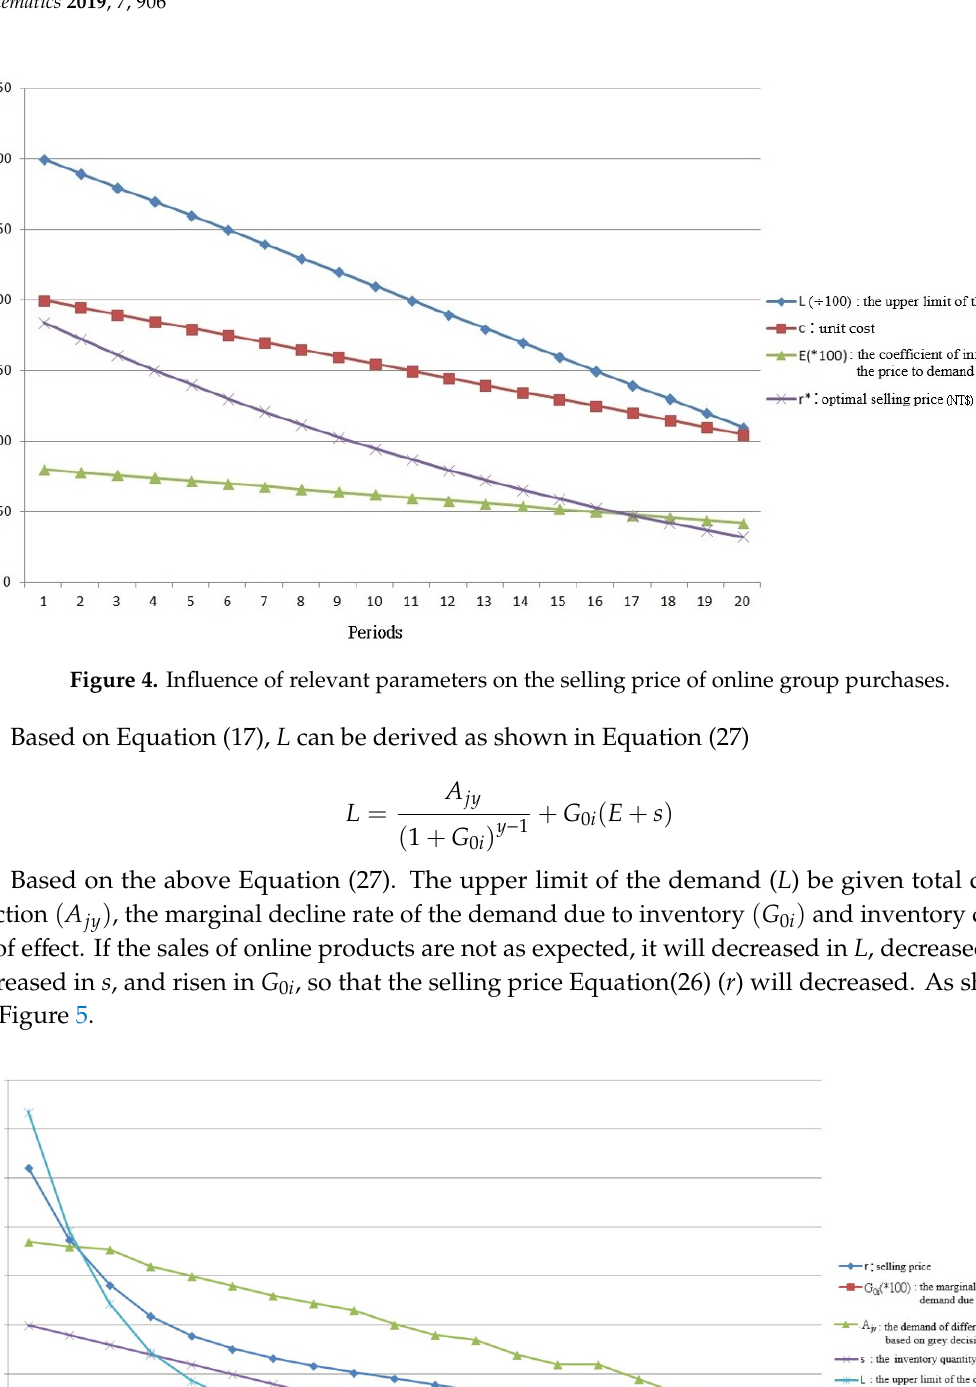
18 of 23 Figure 3. Influence of relevant parameters on commodity shelf-time. 4.1. Commodity Shelf-Time Group buying websites have power because they have a loyal customer base that wants bargains and their own marketing resources. A product was once sold to nearly 2000 groups in one month on a famous group buying website. However, the disadvantage is that after a group buying website is introduced, it is very difficult to sell products at the original price, because even after the end of the offer, customers can still find the historical price records on group buying websites (consumers usually have an expectation psychology). This forms the mentality that consumers are always waiting for anniversary discounts. According to Equation (24) and the estimation of business parameters, c is 200, f